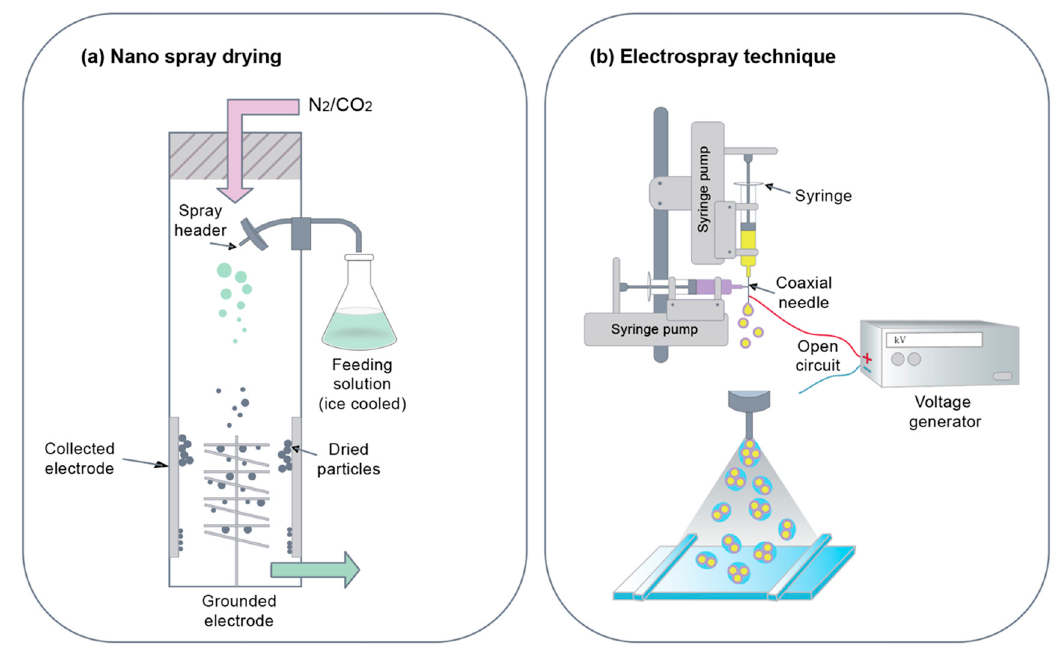
Figure 4. ( a ) Nano spray drying is the process of releasing and drying a protein liquid jet stream with a nozzle using heated nitrogen and carbon dioxide gas to produce nanoparticles. ( b ) The electrospray technique generates nanoparticles by ejecting a liquid jet stream through a nozzle that forms an aerosolized droplet by applying a high voltage to a protein solution supplied through a nebulizer.